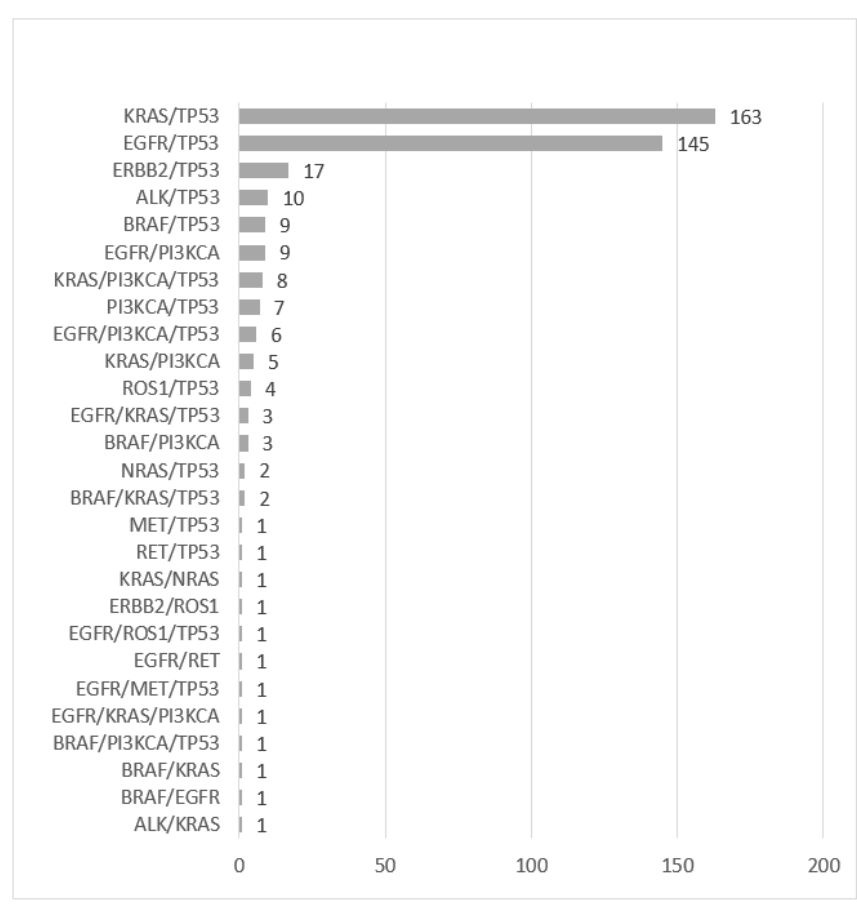
Figure 2. Genomic co-alterations identified (N = 1395 patients). The incremental cost of TST15 beyond reimbursed single gene testing for EGFR and ALK was CAD $233 per